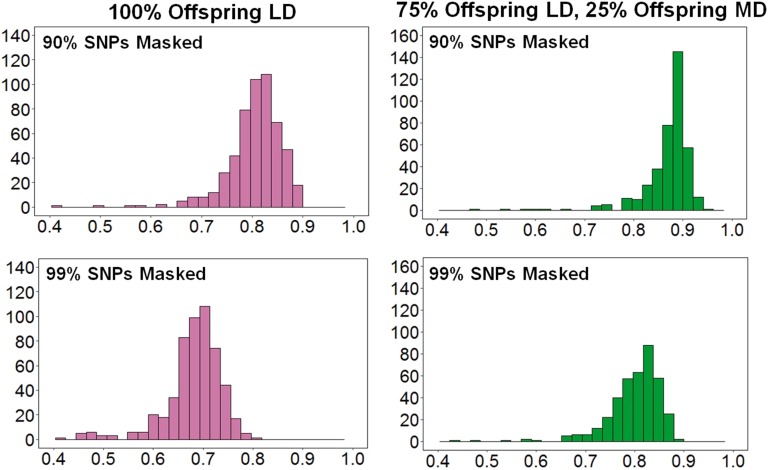
Variation of imputation accuracies across individual animals in MD SNP panel. The histograms show bins of imputation accuracy (x-axis), and the number of animals in those bins (y-axis) for the two different LD SNP panel densities (90% SNPs masked = 2563 SNPs; 99% SNPs masked = 256 SNPs).